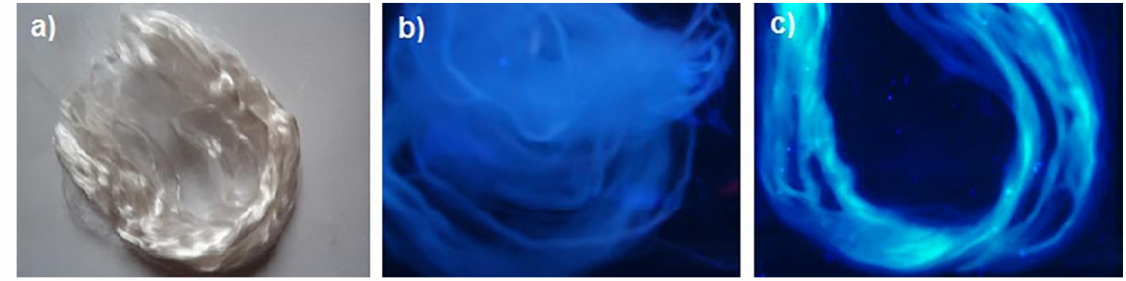
Figure 3. Optical observation of fibers: ( a ) fibers in visible light, ( b ) fibers without modifier under UV lightwitha 365nmwavelength, and( c )fiberswith 0.1wt.%ofKMTunderUV with